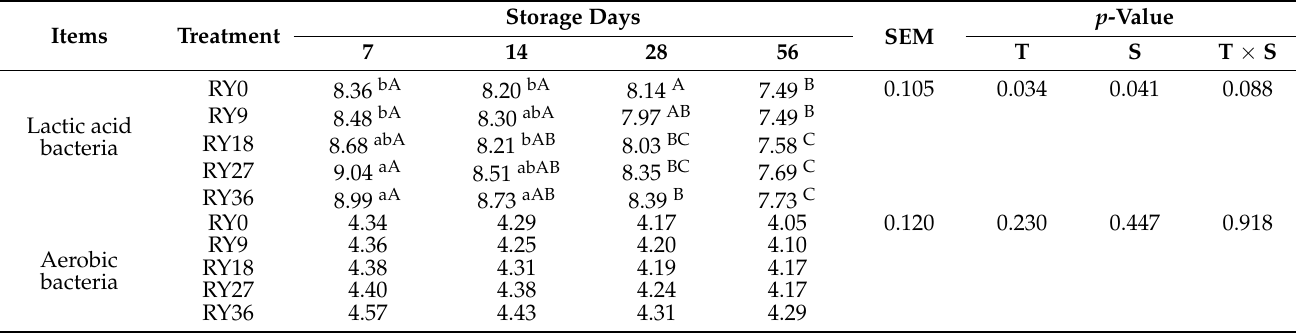
Table 4. Effect of paper mulberry replacement levels and storage days on microbial counts of TMR silages (log 10 cfu/g FM).